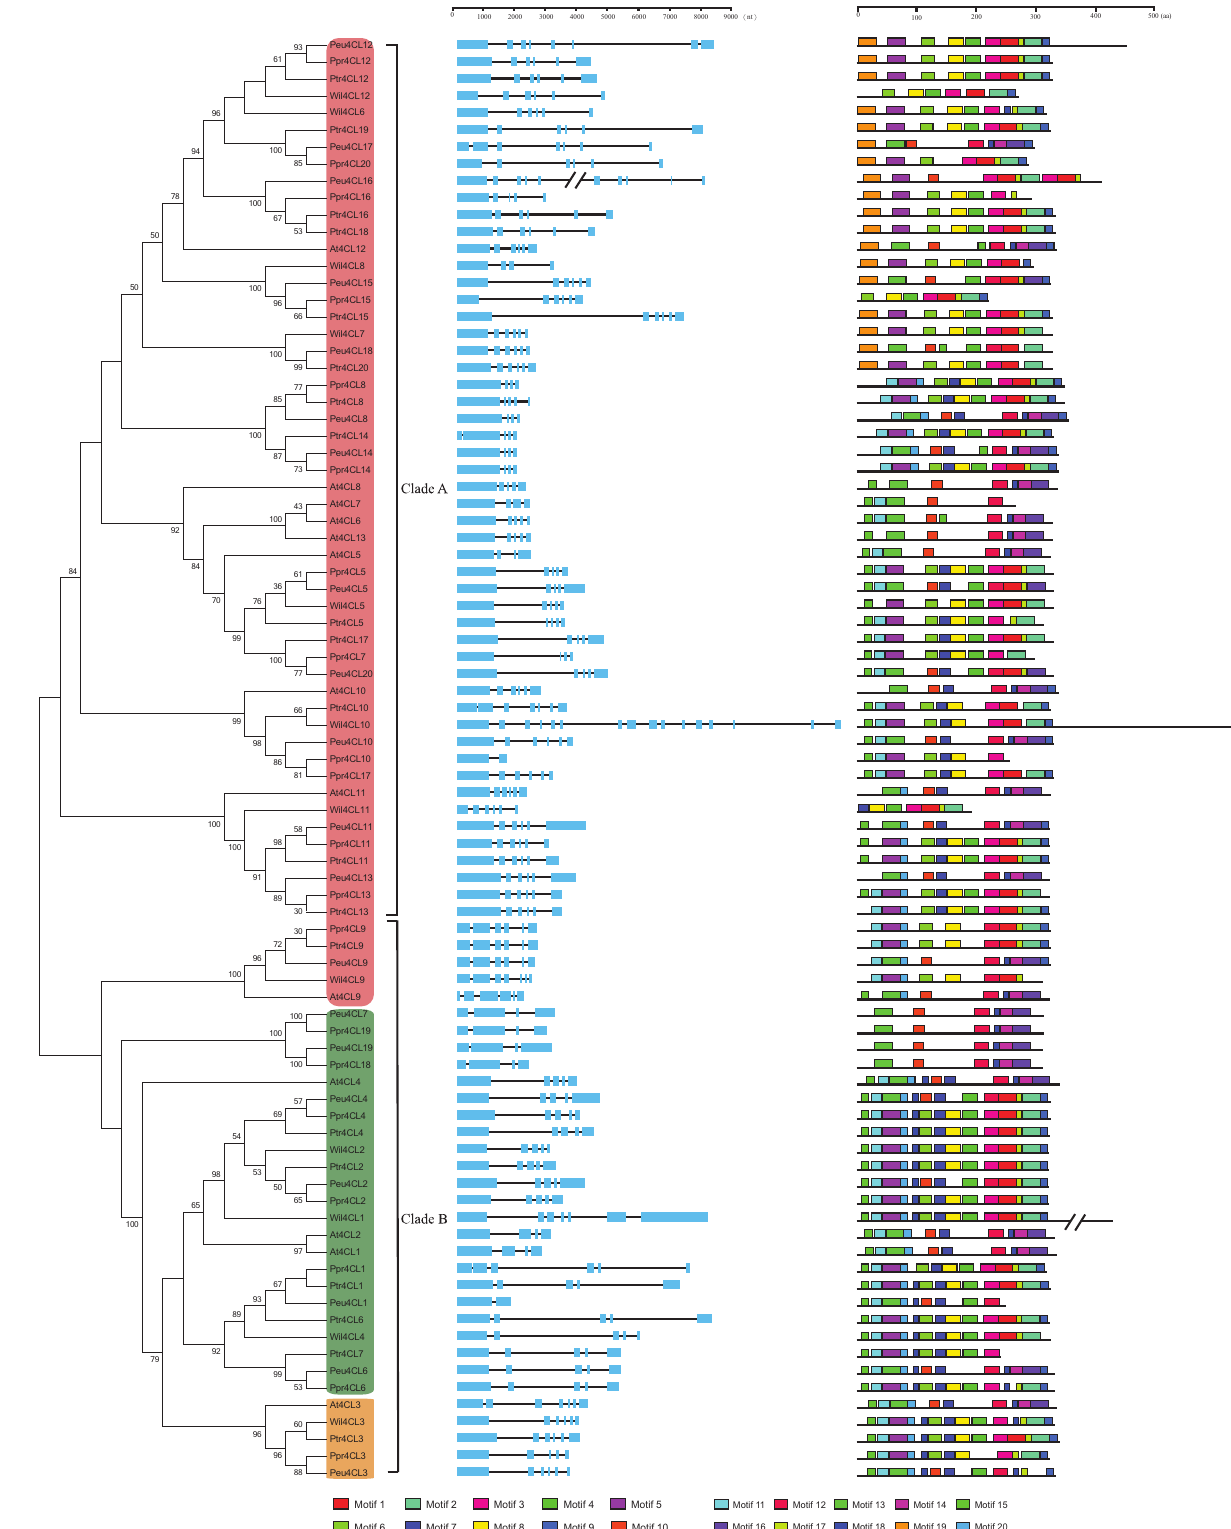
Figure 2. Phylogenetic relationships, gene structure and motif structure of 4CL genes in the five considered species. An un-rooted NJ tree was constructed from the alignment of full-length amino acid sequences of Arabidopsis thaliana (At), P . trichocarpa (Ptr), P . pruinosa (Ppr), P . euphratica (Peu), and Salix suchowensis (Wil) using the MEGA 6 package. Branches with less than 50% bootstrap values were collapsed. The tree divided into two